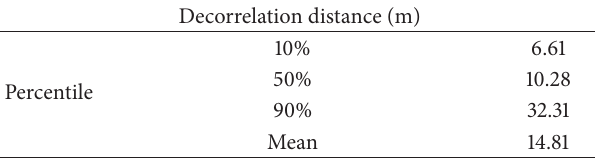
Table 3: Decorrelation distance statistic in hilly terrain.